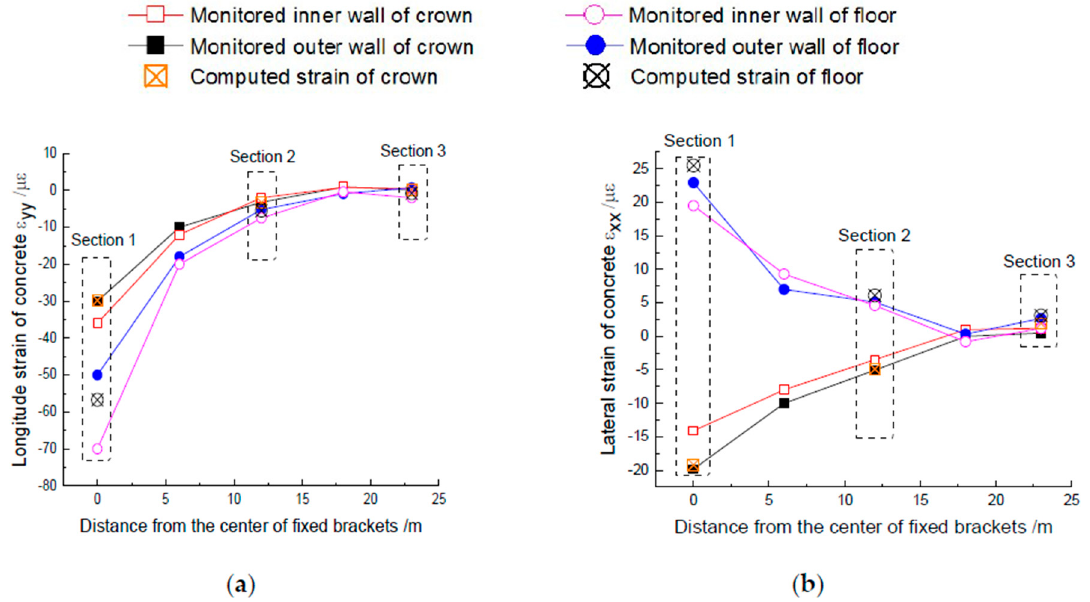
Figure 11. Monitoring results of strain variation of concrete under coupling. ( a ) Longitudinal strain variation of concrete; ( b ) Lateral strain variation of concrete.